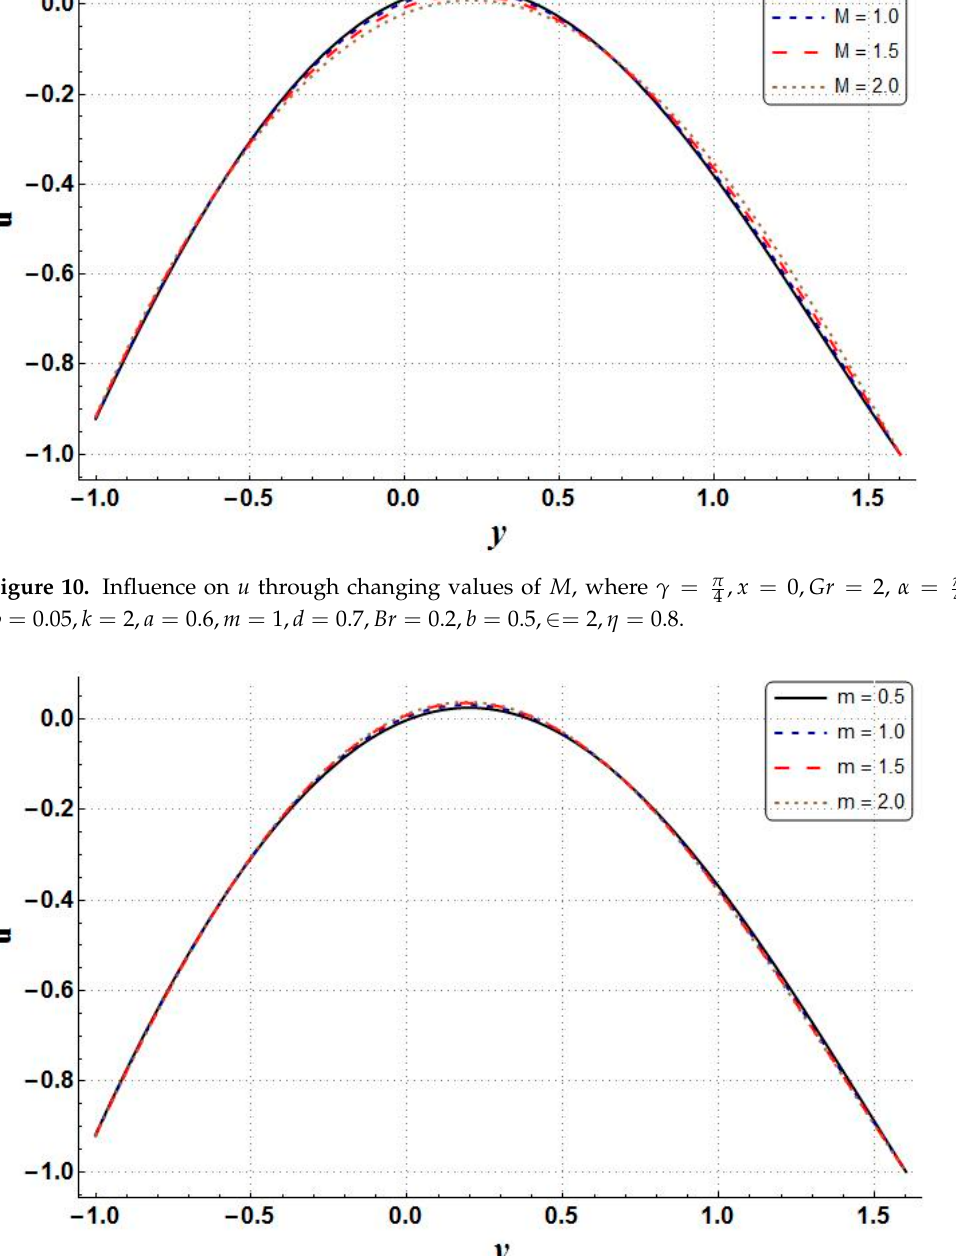
Figure 11. Influence on u through changing values of m , where γ = π φ = 0.05, k = 2, a = 0.6, M = 1, d = 0.7, Br = 0.2, b = 0.5, ∈ = 2, η =